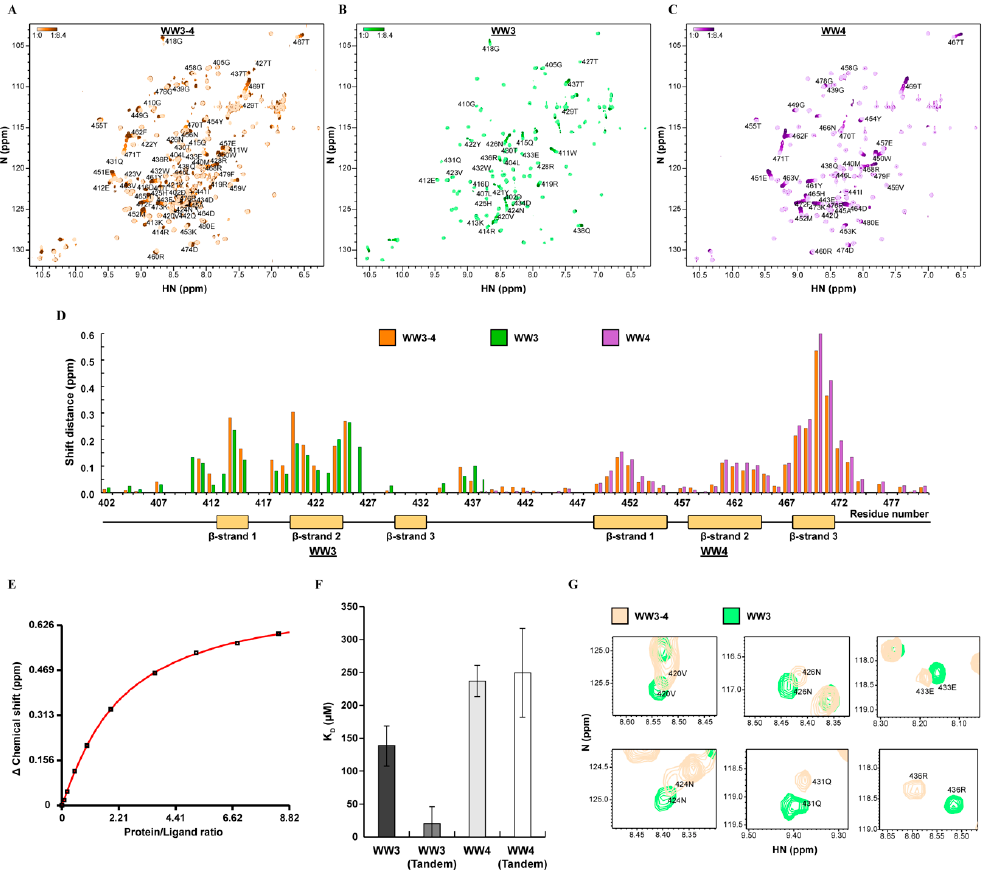
Figure 4. The interaction between tandem WWP2 WW3–4 and Smad7. ( A ) The superimposed WW3–4/Smad7 titration HSQCs. Lower ligand concentrations are in light orange, and higher ligand concentrations are in dark orange. ( B ) The superimposed WW3/Smad7 titration HSQCs. Lower ligand concentrations are in light green, and higher ligand concentrations are in dark green. ( C ) The superimposed WW4/Smad7 titration HSQCs. Lower ligand concentrations are in light purple, and higher ligand concentrations are in dark purple. ( D ) The shift distances of the WW3–4/Smad7 (orange), WW3/Smad7 (green) and WW4/Smad7 (purple) titration HSQC amide peaks in ppm. The WW3–4 secondary structure is aligned to the residue number along the x-axis, with β -strands represented as yellow boxes. ( E ) The WW3–4/Smad7 binding curve K D fit. ( F ) The WW3/Smad7 (139 ± 14.4 µM), WW3(tandem)/Smad7 (20.57 ± 26.24 µM), WW4/Smad7 (237 ± 15.7 µM) and WW4(tandem)/Smad7 (249.3 ± 68.1 µM) dissociation constants. ( G ) HSQC peaks belonging to the WW3 domain at different chemical shifts for WW3–4 (orange) and WW3 (green).